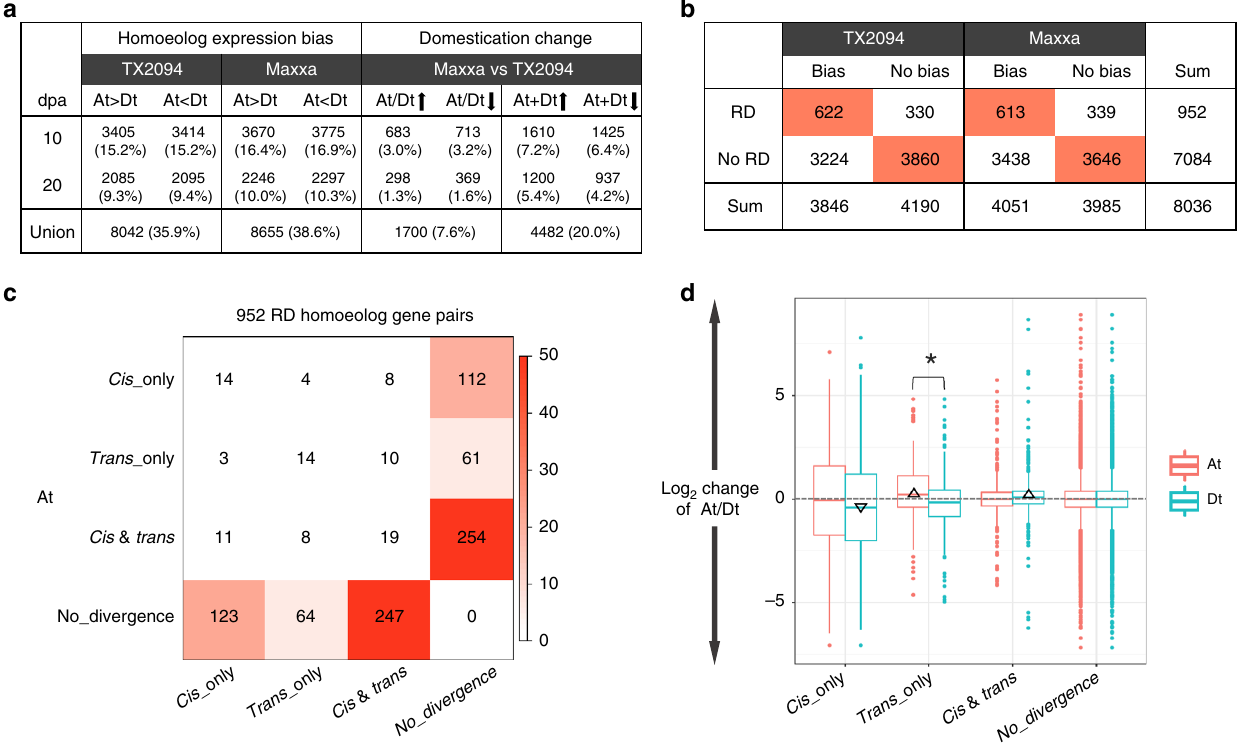
Fig. 4 Regulatory evolution and homoeolog expression. a The extent of homoeolog expression bias (1st and 2nd columns) and expression changes under domestication (ratios, At/Dt, and total expression, At + Dt; 3rd and 4th columns, respectively) were measured for 22,394 homoeologous gene pairs. b Contingency tables between cis and trans regulatory divergence and homoeolog bias. A pair of homoeologous genes was considered to exhibit regulatory divergence (RD) if at least one homoeolog was found to be a RD gene (1st row). Homoeolog expression bias was characterized each within TX2094 and Maxxa (columns). Cells displaying signi fi cant over-representation (Fisher ’ s exact test; P < 0.05) are highlighted. c Cross-tabulation of regulatory evolution for 952 RD homoeolog pairs, indicating predominance of cis and trans effects. Cell color indicates the magnitude of signi fi cant over-representation based on − log P -value) of Fisher ’ s exact test (i.e., P = 0.05 is converted to 1.3). d Boxplot of homoeolog expression ratio changes under domestication for RD 10 ( homoeolog pairs. Black triangles indicate signi fi cant deviation from zero (Student ’ s t -test; P < 0.05), and the asterisk (*) denotes a signi fi cantly different ratio between At and Dt homoeologs. Boxplot elements: center line – median; box limits – upper (Q3) and lower (Q1) quartiles; whiskers – smallest and largest non-outlier; points – outliers. The source data underlying Fig. 4d are provided as a Source Data fi